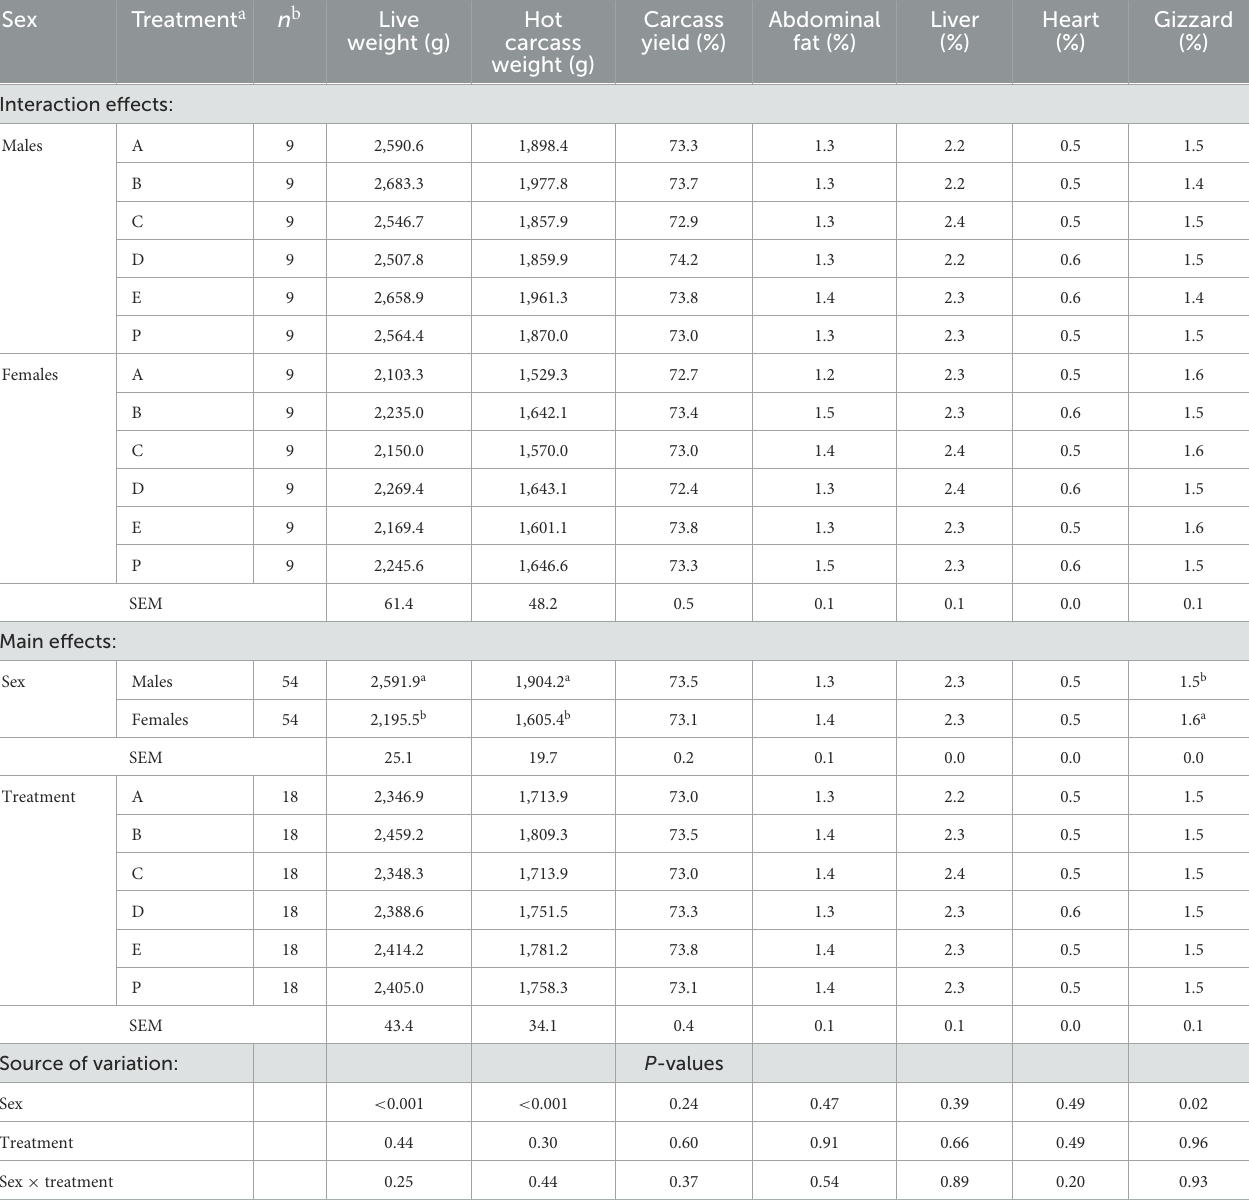
TABLE 6 Effects of adding nano-emulsified plant oil and probiotics to drinking water during different periods besides sex on carcass measurements of broiler chickens at 35 days of